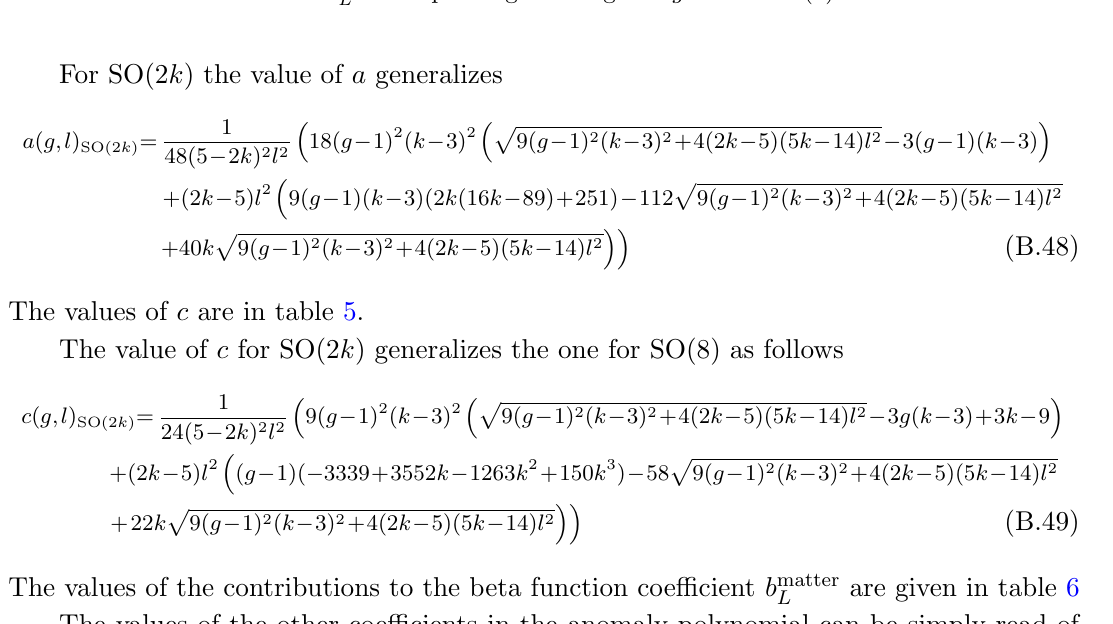
Table 6 . Value of b matter depending on the genus g and the U(1) (cid:13)ux l on L